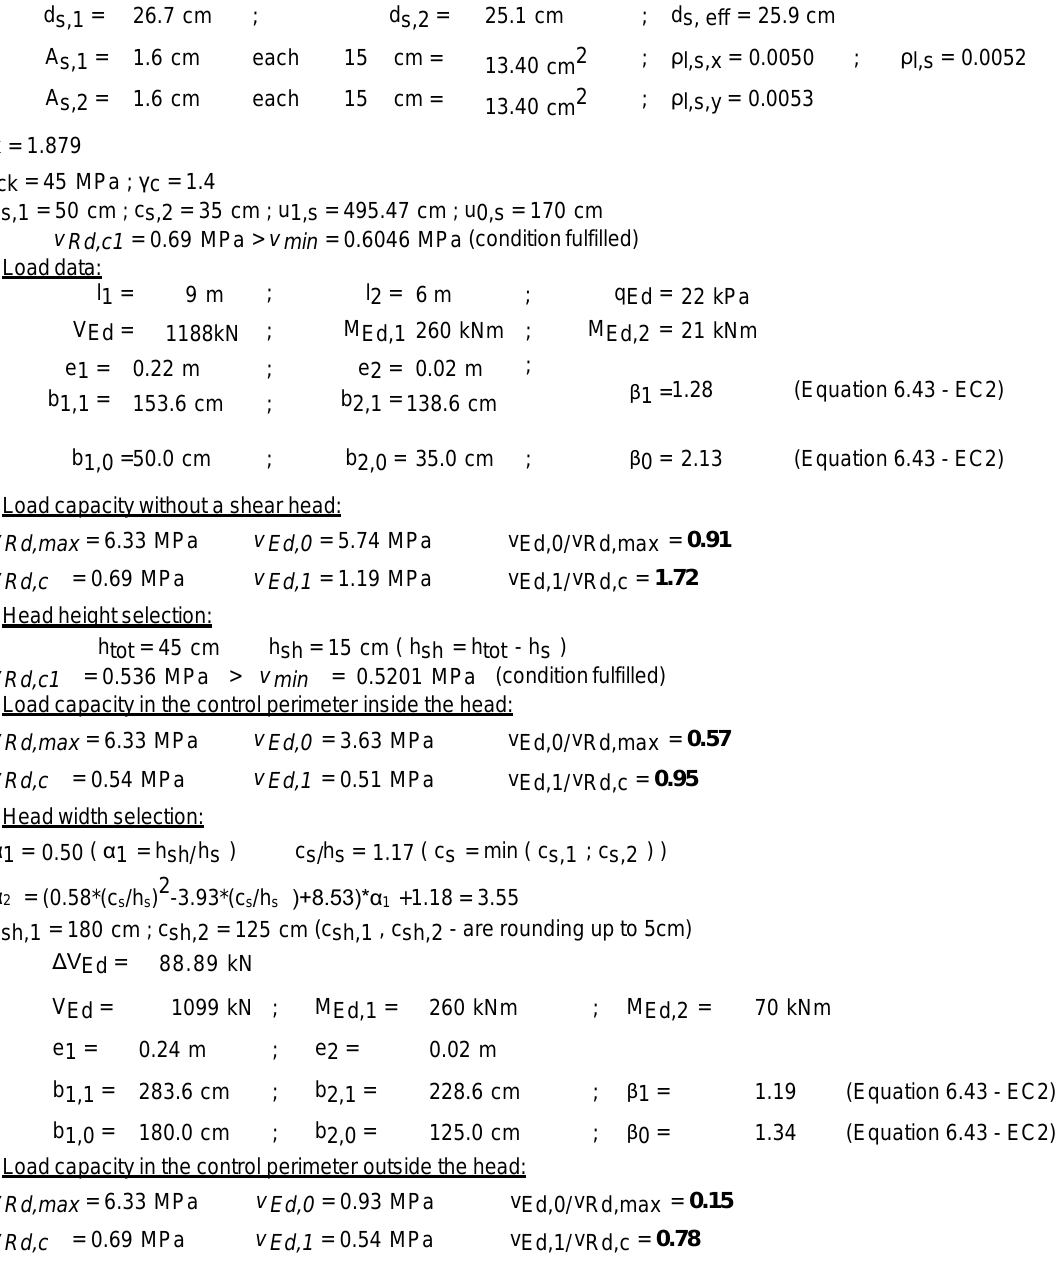
Figure A4. Verification example no. 4—EC2.